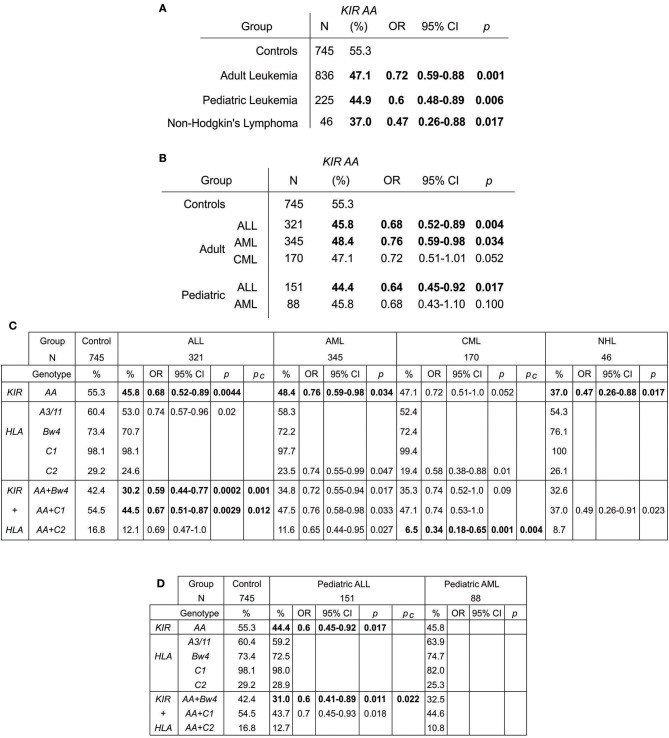
The KIR AA genotype associates with protection against leukemia. (A,B) Odds ratios and statistical significance obtained by comparing the KIR AA genotype frequencies of healthy controls with (A) adult and pediatric leukemia cases and non-Hodgkin's lymphoma, and (B) with the subtypes of leukemia. Statistically significant values are indicated in bold. (C). Genotype frequencies, odds ratios and statistical significance obtained by comparing healthy controls (left), with three leukemia types, ALL, AML and CML (center), and NHL (right). The genotypes are: KIR AA genotype (top), the four KIR ligands (center) and KIR AA genotype in combination with each ligand (bottom). Only those results having 95% CI that do not encompass 1 are shown. Pc–Bonferroni correction factors used were x4 for ligands and x3 for ligand+KIR AA. Bold indicates p-value remains significant after this correction. (D) Shows the equivalent values obtained for pediatric ALL and AML.